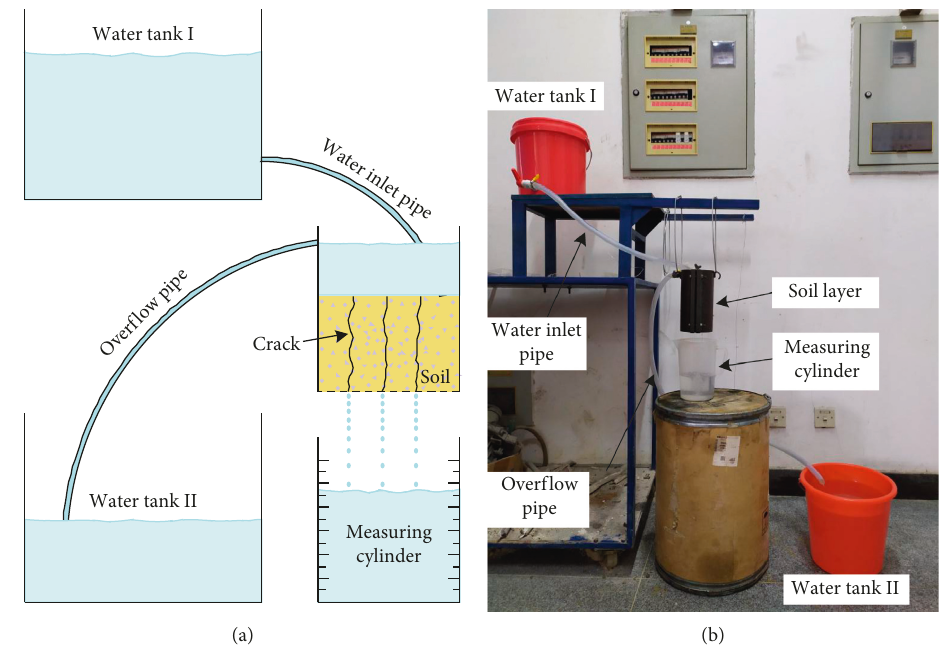
Figure 5: Experimental device for crack development-closure in soil layer: (a) schematic diagram of the experimental device; (b) ex- perimental device.